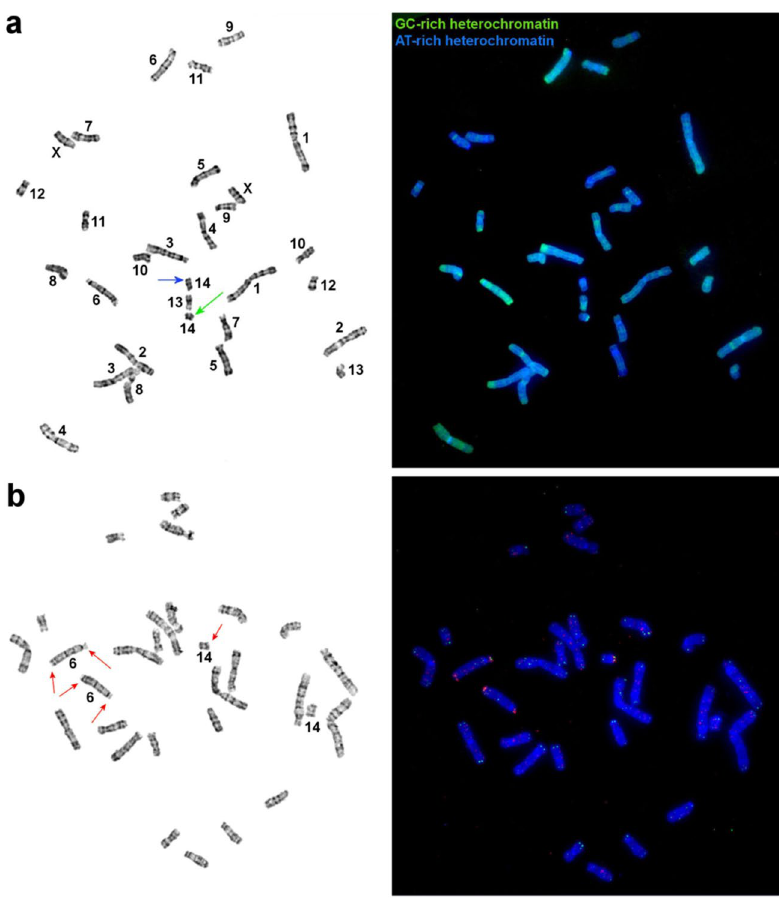
Figure 2. ( a ) CDAG-banding of U. kamensis chromosomes; the blue arrow points to a block of AT-rich heterochromatin on one of the homologs of the pair of chromosomes 14, and the green arrow indicates a block of GC-rich heterochromatin on the other homolog of this pair. ( b ) Localization of telomeric (green) and rDNA (red) probes on U. kamensis chromosomes; red arrows mark rDNA clusters. G-banded metaphases are shown on the